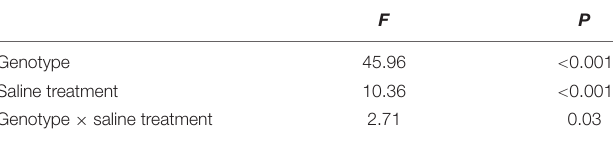
TABLE 5 | Two-way ANOVA examining the effects of genotype, saline treatment and their interaction (genotype × saline treatment) on the V L of leaves from the three P. amurensis sample types.